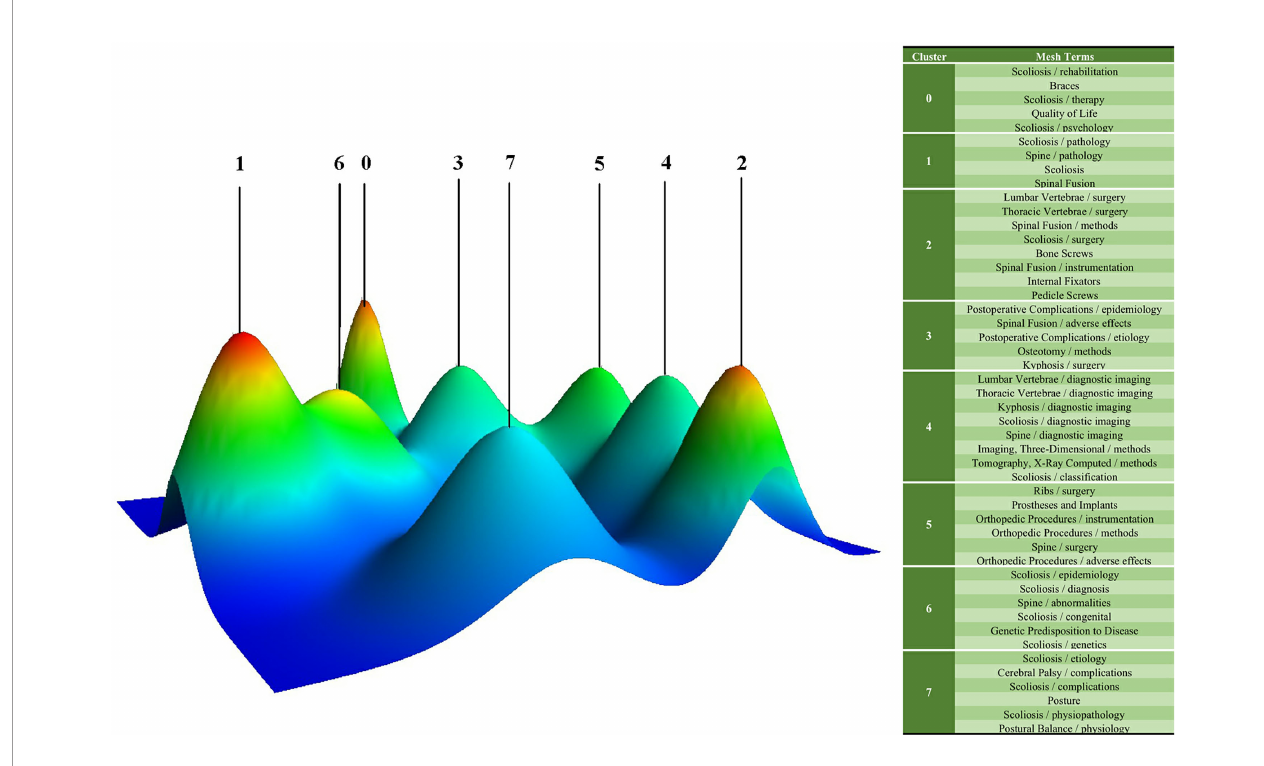
FIGURE 5 | Mountain visualization of the eight hot spots by biclustering.